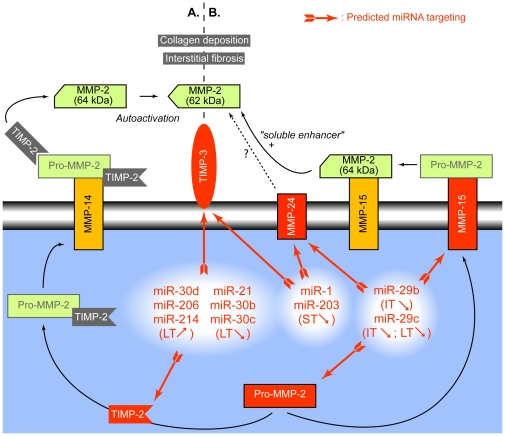
miRNAs and MMP-2 activation.Panel A represents MMP-14 (MT1-MMP)-dependent activation pathway for MMP-2. TIMP-2 activates pro-MMP-2 by forming a complex that interacts with the MMP-14/TIMP-2 complex at the cell membrane. Activation of pro-MMP-2 occurs in a two step process: cleavage within the MMP-2 prodomain followed by an autocatalytic cleavage which results in the active 62 kD form. Panel B represents the presumed MMP-15 (MT2-MMP) and MMP-24 (MT5-MMP)-dependent activation pathway for MMP-2. Activation of pro-MMP-2 occurs in a two step process: cleavage within the MMP-2 prodomain in the absence of TIMP-2 followed by a second cleavage, enhanced by an unidentified secreted soluble protein which results in the active 62 kD form. The mechanism by which MMP-24 releases active MMP-2 is currently unknown. The intensive activation of MMP-2 contributes to collagen deposition and interstitial fibrosis. An excess of TIMP-2 and the extracellular matrix-anchored TIMP-3 contribute, respectively, to the degradation of pro-MMP-2 and to the inhibition of MMP-2. ST, IT, LT: short, intermediate and long-term treatments, respectively. The observed up- (<$>\raster="rg1"<$>) and down- (<$>\raster="rg2"<$>) regulations of the expression of some specific miRNA are reported.